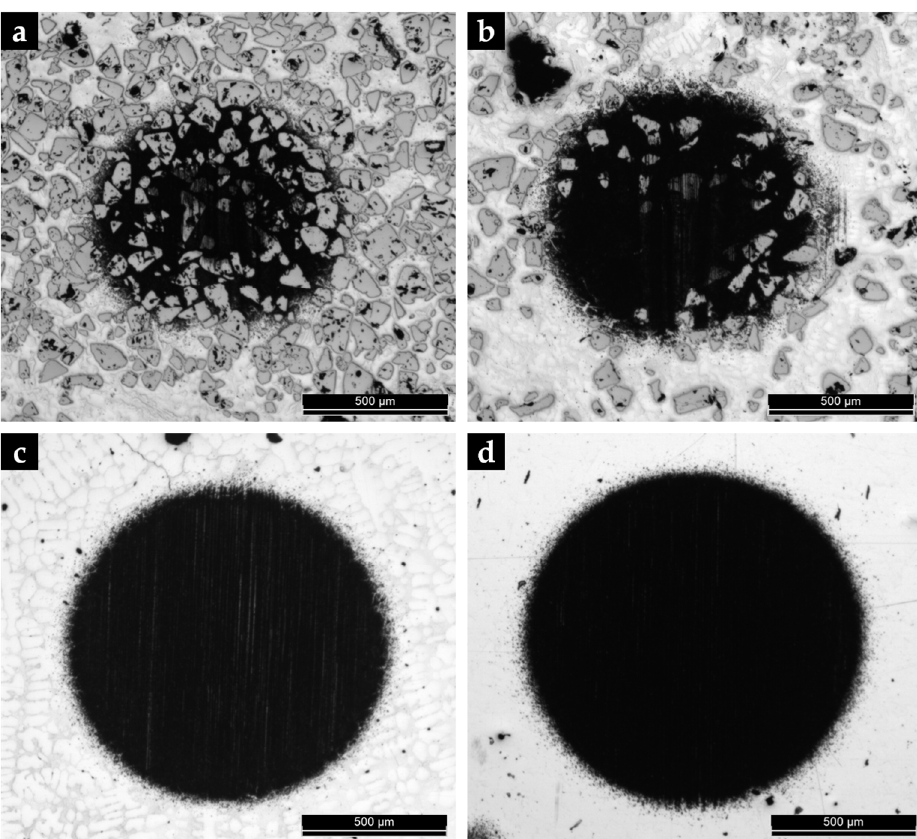
Figure 8. OM images of the worn craters corresponding to a sliding distance of 15.7 m: ( a ) CZ1 composite zone, ( b ) CZ2 composite zone, ( c ) CZ3 composite zone, and ( d ) base metal.